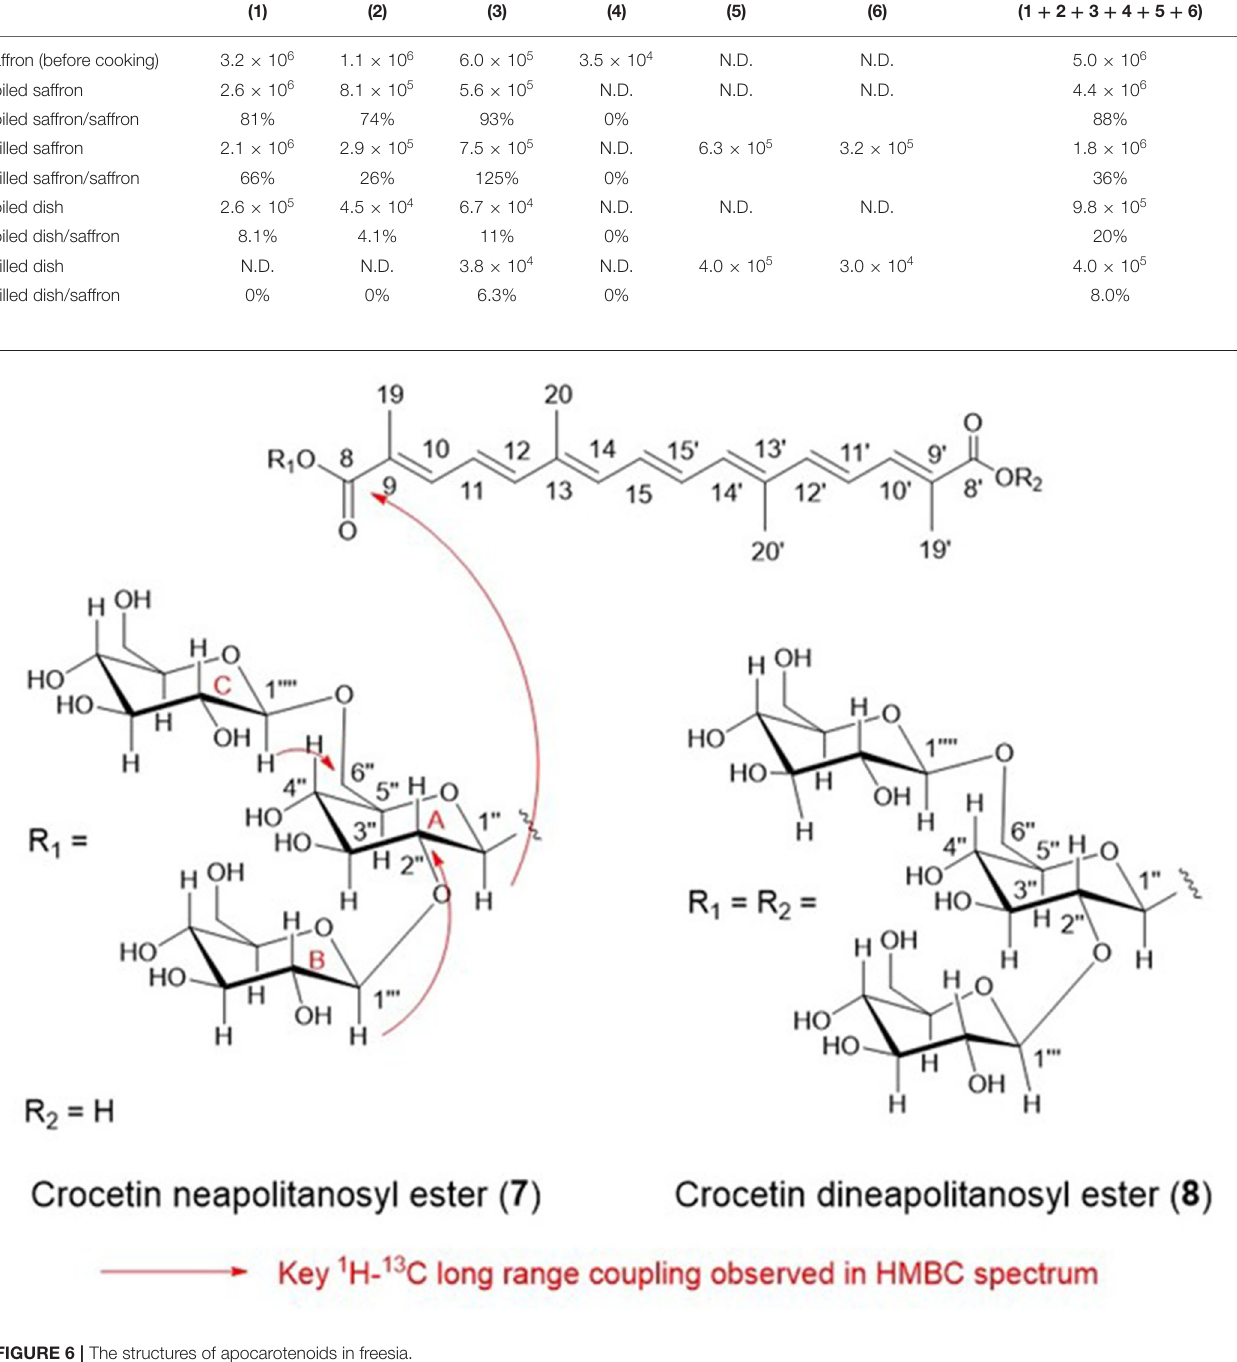
TABLE 1 | HPLC peak areas (mV × s) of apocarotenoids in cooked saffron at 440nm. Cooking \ apocarotenoid